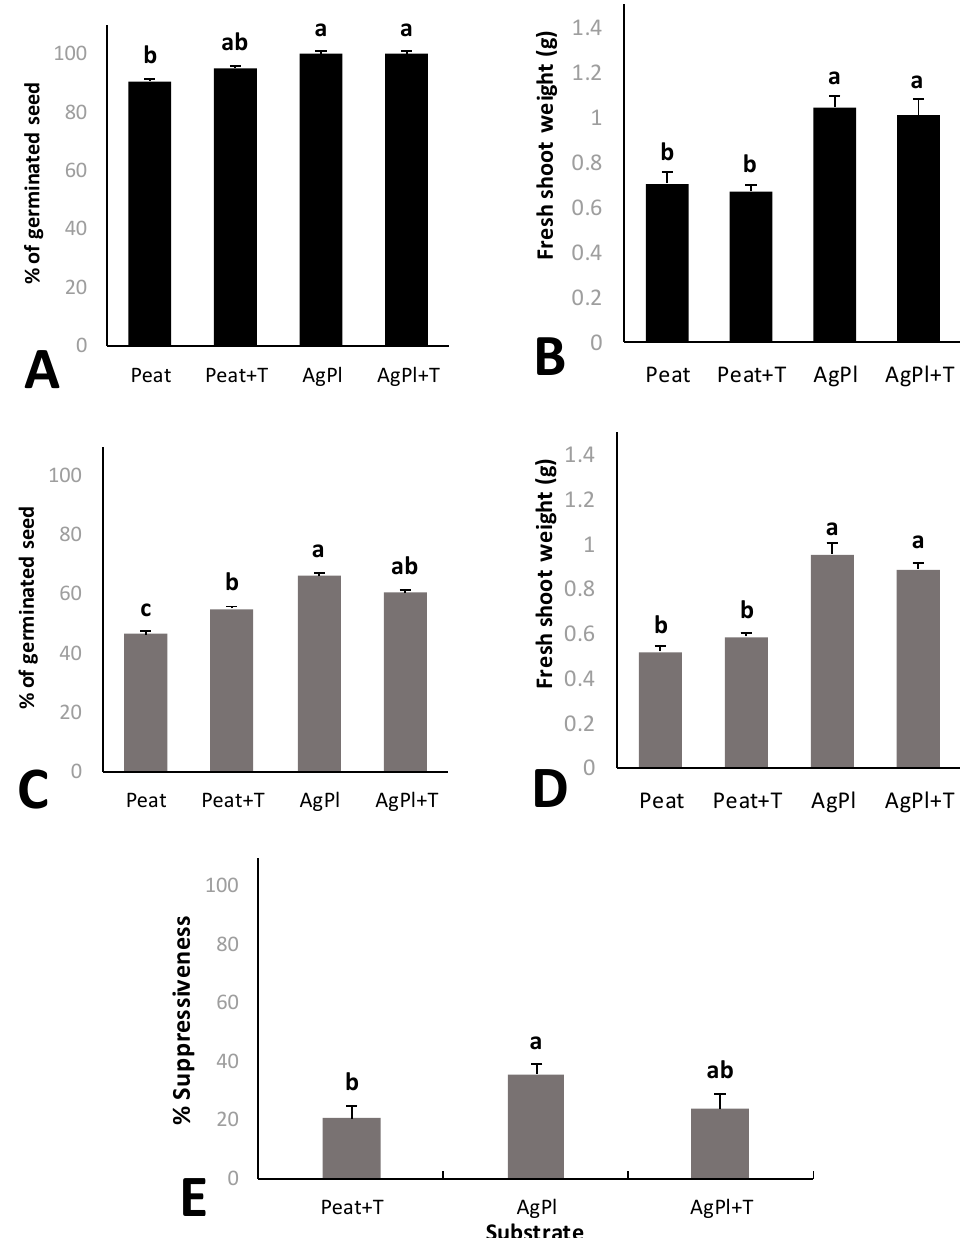
Figure 3. Germinated seed percentage ( A ) and fresh shoot weight of baby red lettuce plants ( B ) without pathogen. Germinated seed percentage ( C ) and fresh shoot weight of baby red lettuce plants with P. irregulare ( D ). Suppressiveness index (%) against P. irregulare ( E ). Error bars represent the standard errors. Values with the same letter do not differ significantly according to Tukey’s post hoc test ( α < 0.05). Peat; Peat + T. harzianum (Peat + T), (70% A. bisporus and 30% P. ostreatus ) + T. harzianum (AgPl + T).